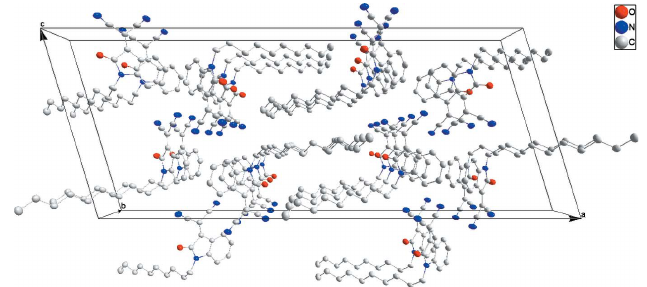
Figure 2 The packing viewed along the b axis.